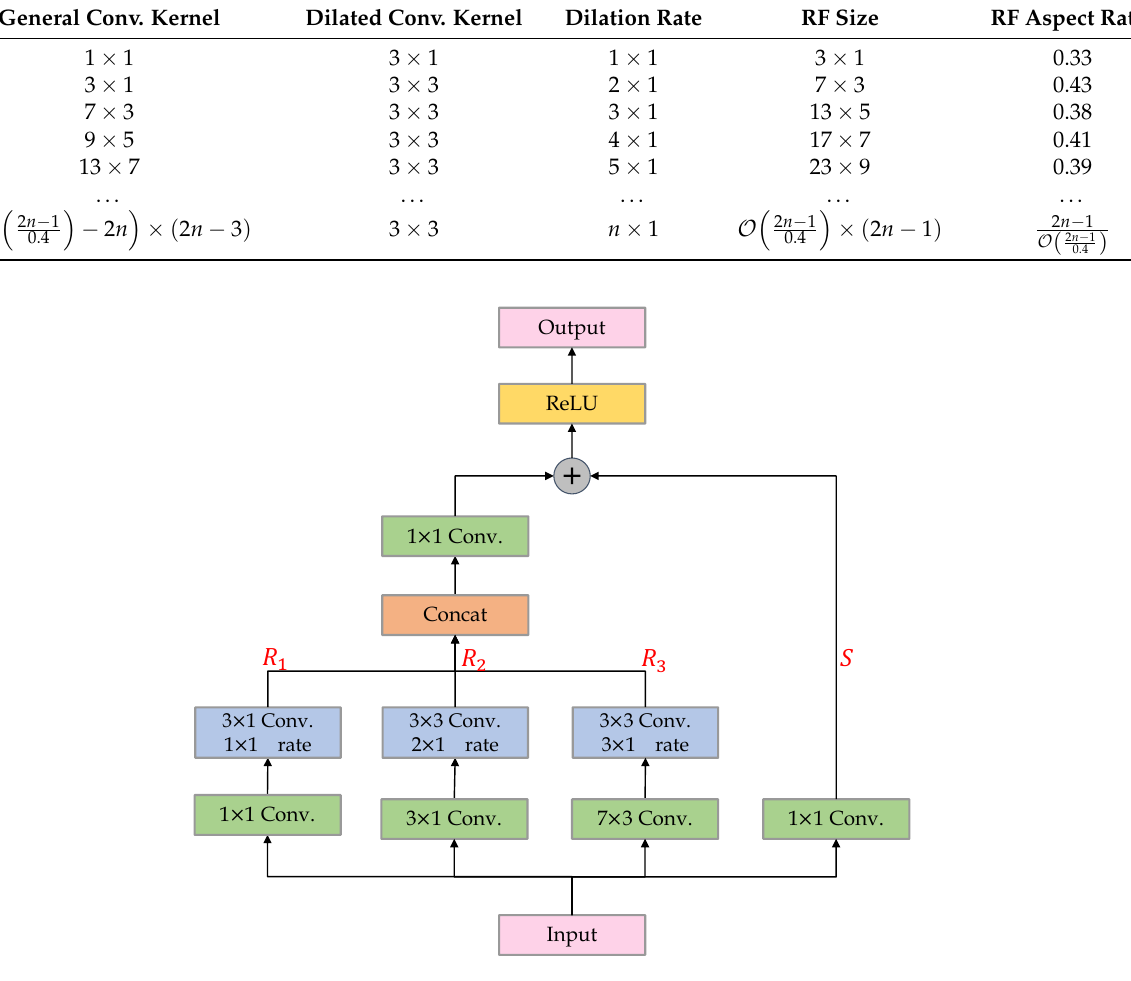
Figure 3. The structure of the proposed attribute-guided multiple receptive field (AMRF)